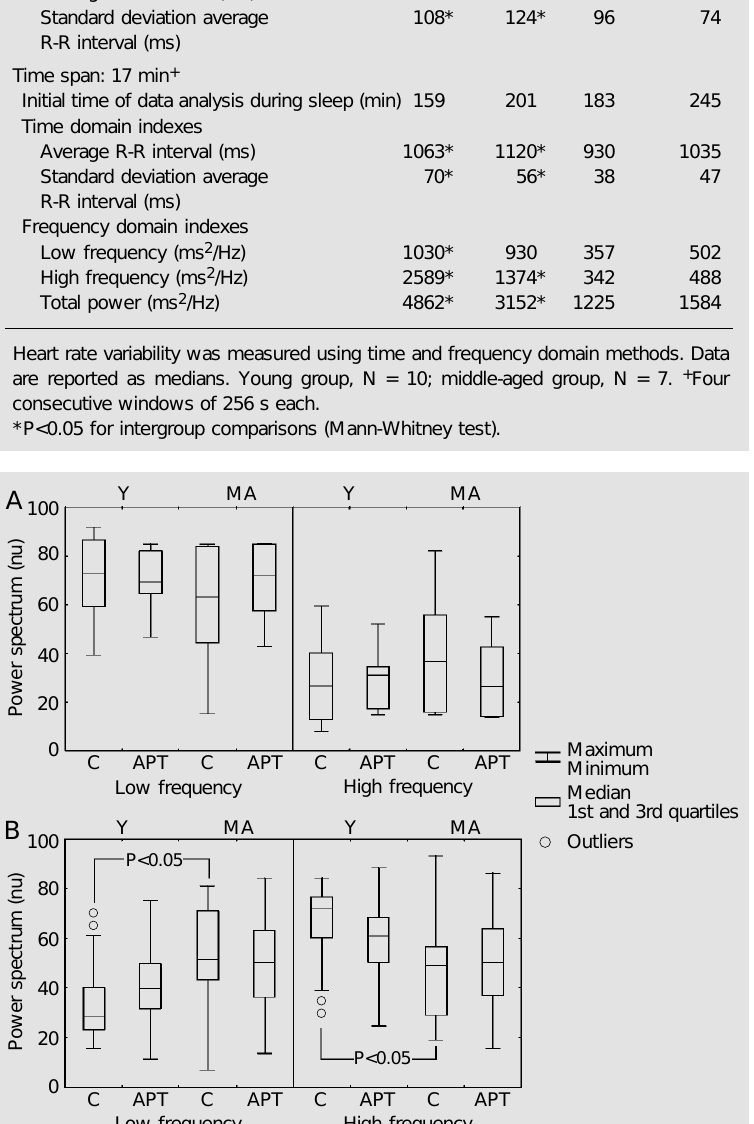
Figure 1. Low and high frequency power spectral components in normalized units (nu), obtained during awake (A) and sleeping (B) conditions, in the young (Y) and middle-aged (MA) groups, during control (C) conditions and after aerobic physical training (APT). Data are reported as box-plots. P<0.05 obtained by the Mann-Whitney test.